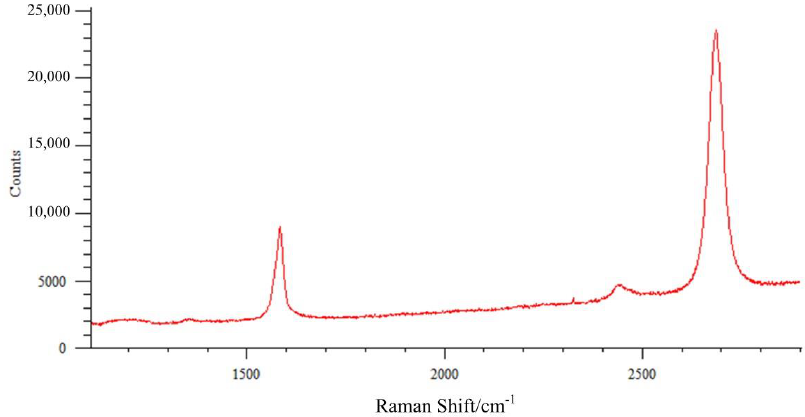
Figure 5. The graphene ’ s Raman spectrum on the electrode area.